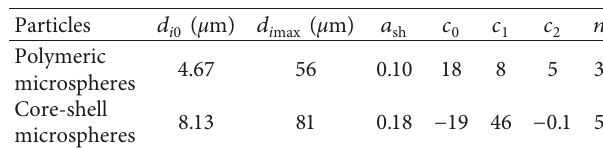
Table 1: Coefficients by matching average